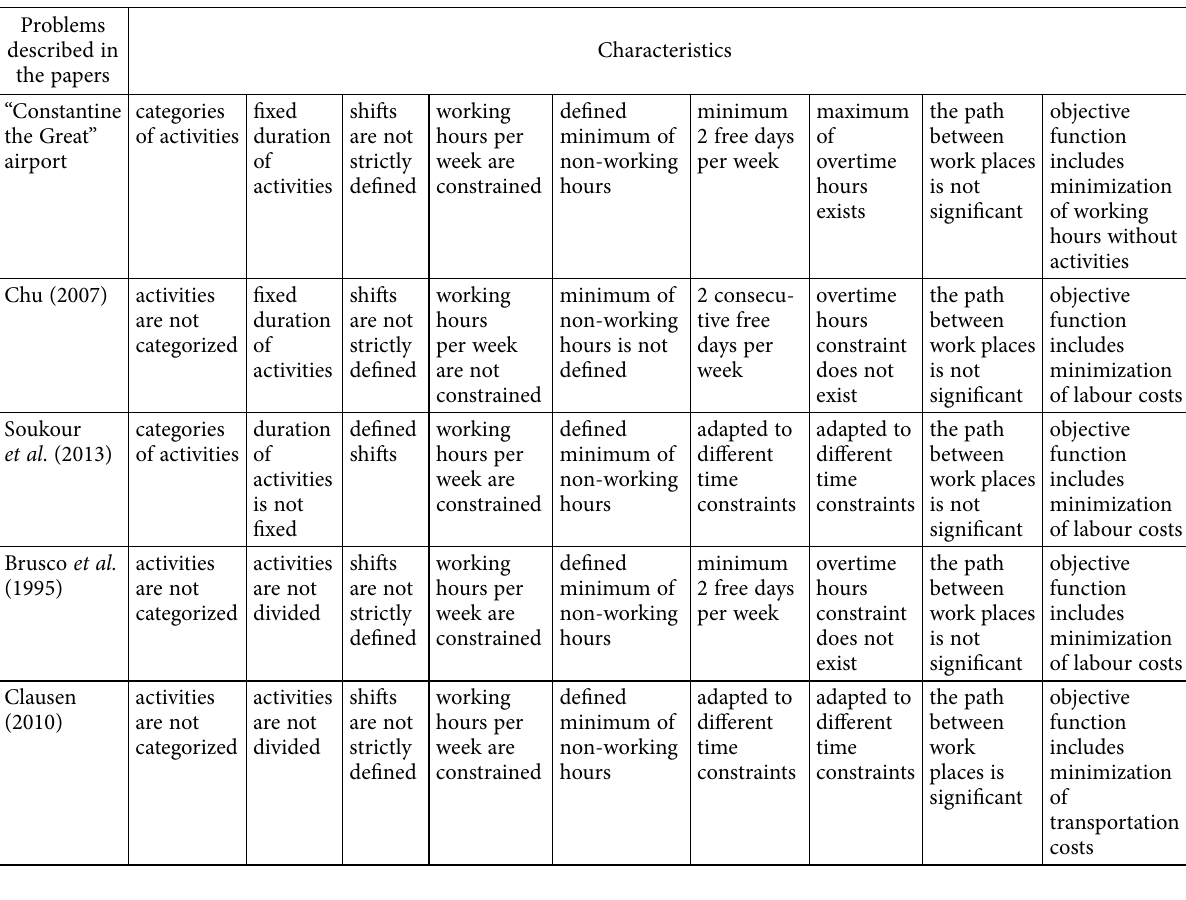
Table 2. Comparison of scheduling problem